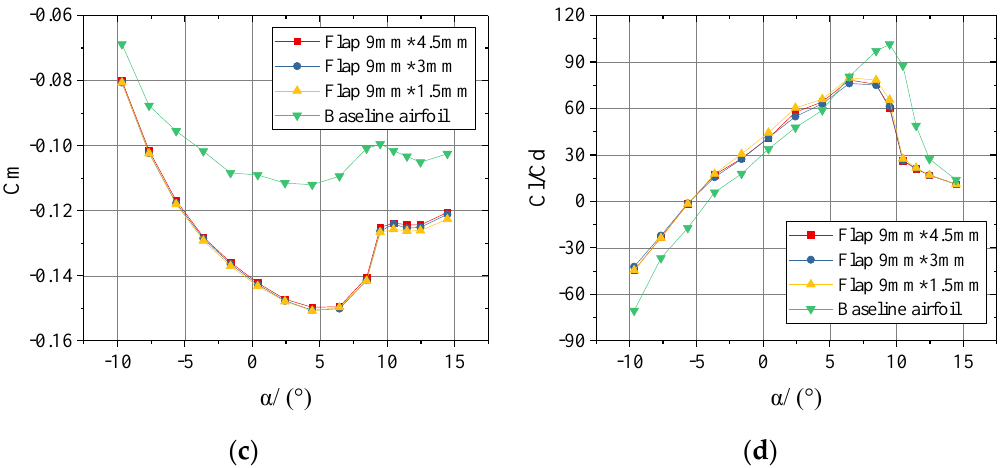
Figure 11. Variation of the aerodynamic characteristics with different thicknesses of Gurney flaps (uniform flow, Re: 0.8 × 10 6 ). ( a ) Lift coefficient comparison; ( b ) drag coefficient comparison; ( c ) pitching-moment coefficient comparison; ( d ) lift-to-drag ratio comparison.